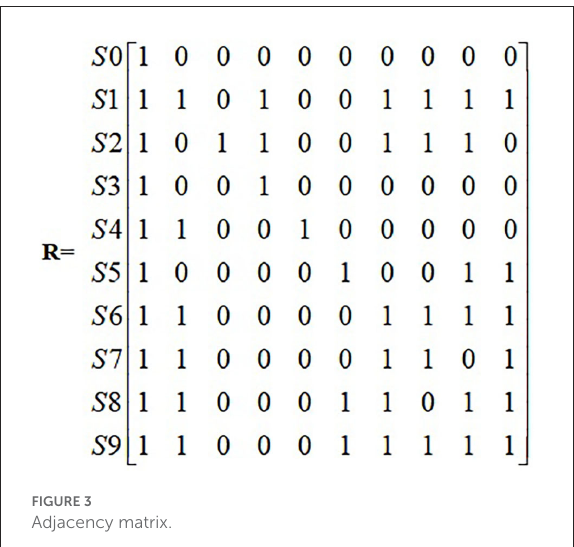
participants (82.6%) were cared for by their families and 2.8% of them with